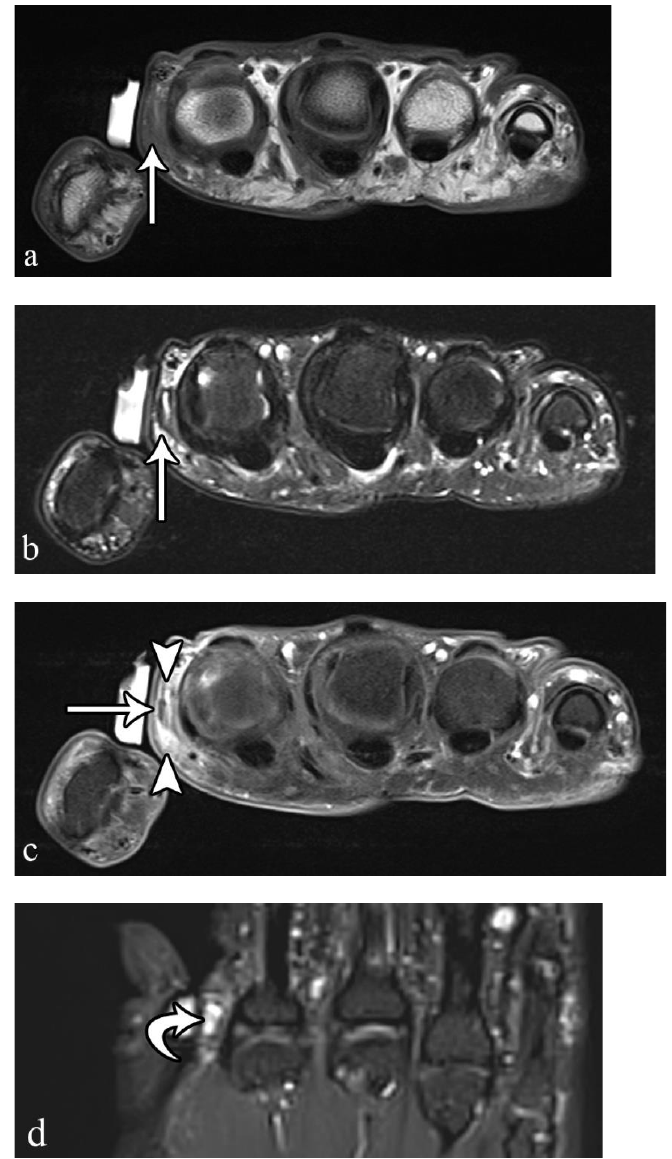
Figure 5. A 49-year-old man with left index finger pain and laceration after a wood-working injury at 6 weeks prior. Axial T1 (a ), T2 FS ( b ), post-contrast T1 FS ( c ), and Cor PD FS ( d ) MRI demonstrate an 8 mm linear hypointense foreign body (arrows) with surrounding enhancement (arrowheads) and fluid signal intensity (curved arrow), compatible with a foreign body granuloma.